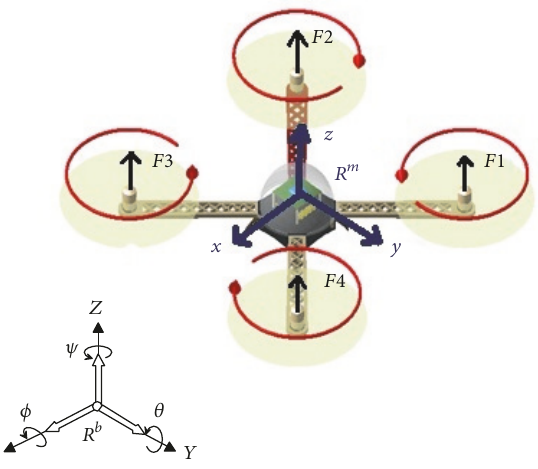
Figure 1: Quadrotor configuration frame scheme with body-fixed and inertia